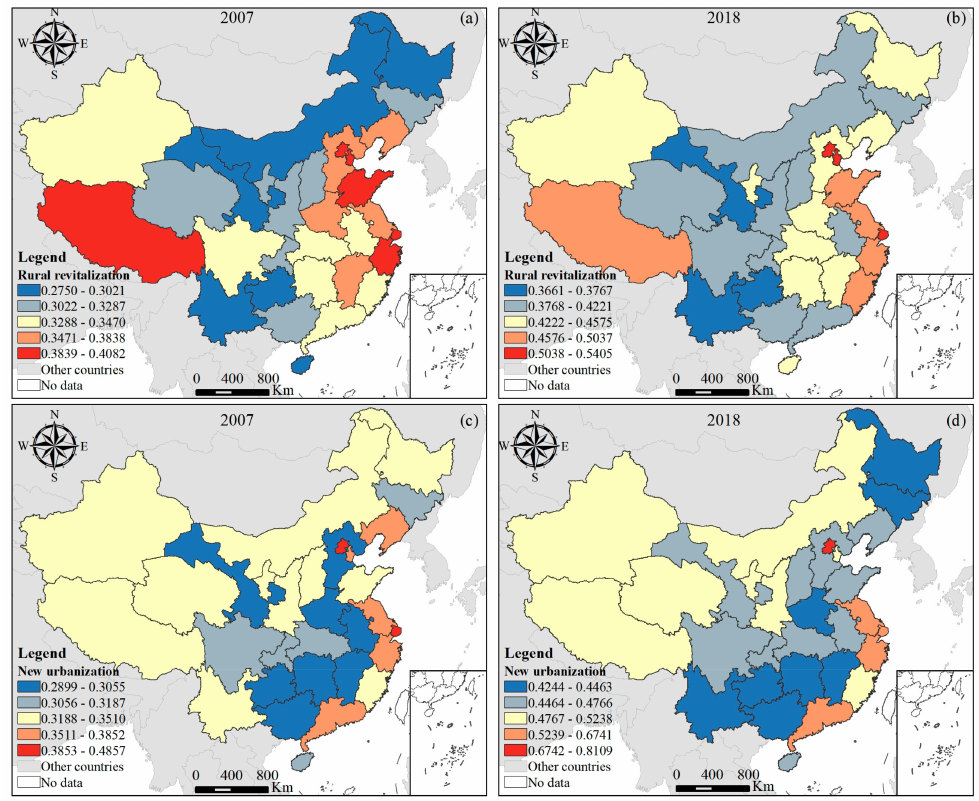
Figure 4. ( a – d ) Spatial and temporal evolution of rural revitalization and new urbanization. (Source: made by